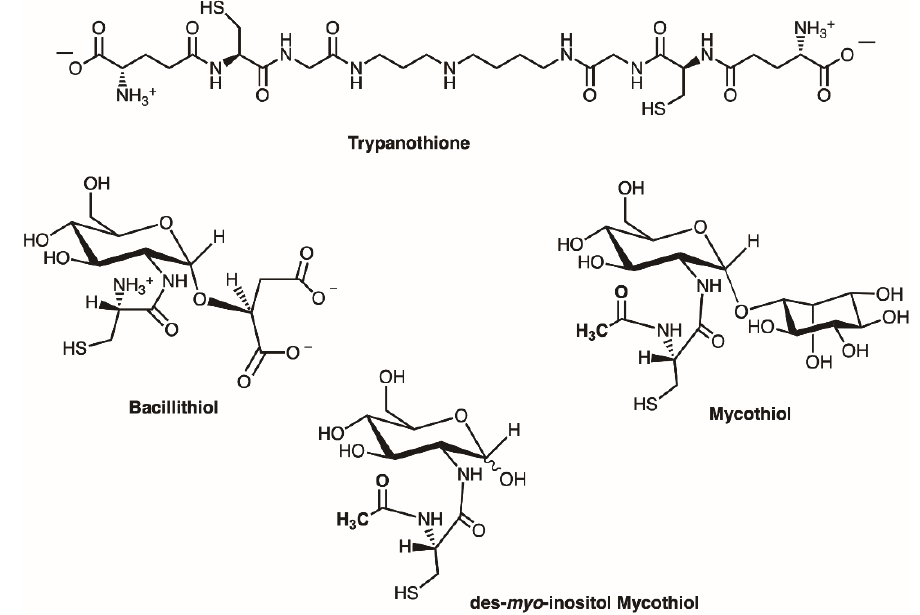
Figure 3. Several important intracellular thiols found in nature (trypanothione, bacillithiol, mycothiol). Des- myo -inositol mycothiol (tMSH) is an analog of mycothiol also employed in the current